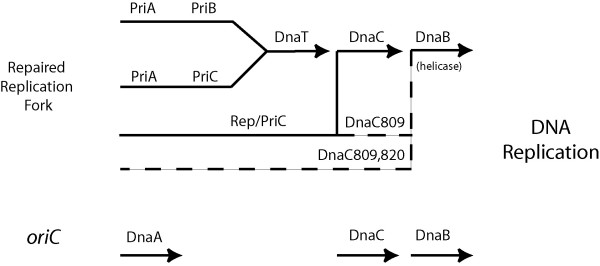
This diagram compares the ways in which the replicative helicase can be loaded either from oriC or a repaired replication fork in E. coli. Left side of the diagram indicates the starting substrate to which the replisome is to be loaded. The horizontal arrows indicate the way in which the proteins may interact to load the replisome. The dotted lines represent suppressor pathways.